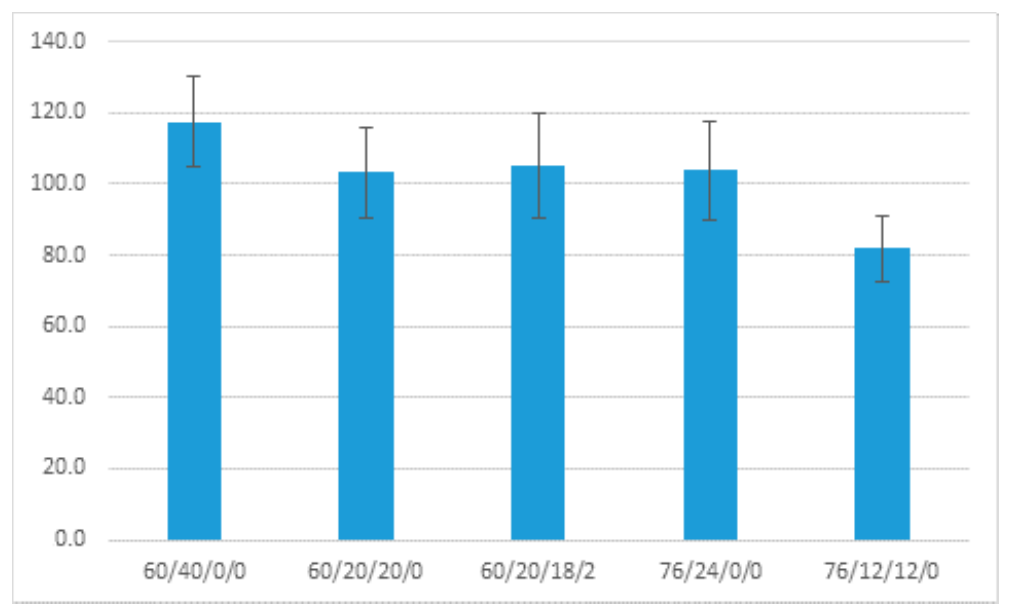
Figure 4. Contact angle determination for five fabric blends. Numbers in x-axis represent percentages of greige cotton, polypropylene, bleached cotton, and blue polyester fibers.